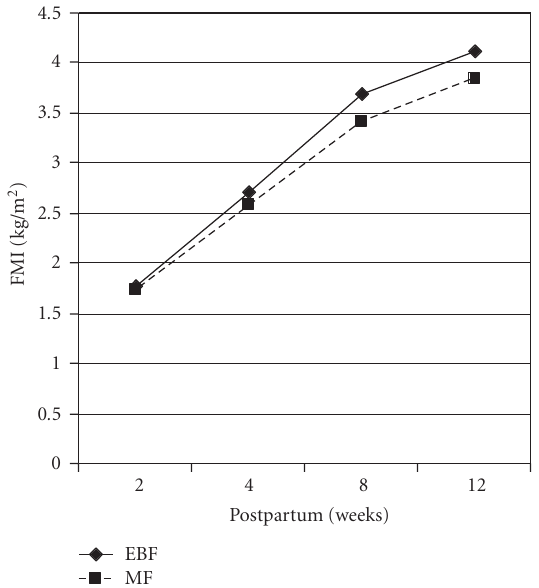
Figure 2: Pattern of infant adiposity with time ( EBF: exclusive breastfeeding; MF: mixed